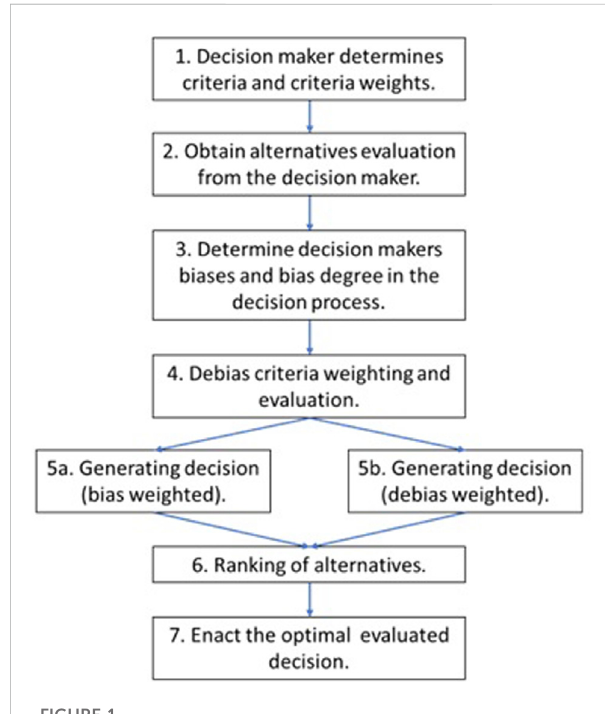
FIGURE 1 Flow diagram of the debiasing process. Inspired by the methodologyfromDeniz(2020).Eachboxinthe fl owdiagramindicates an action that is taken in the debiasing process with this methodology. The arrows between the boxes are unidirectional and indicate a transfer of information from one action to another action. The most important actions in the process are actions 5a and